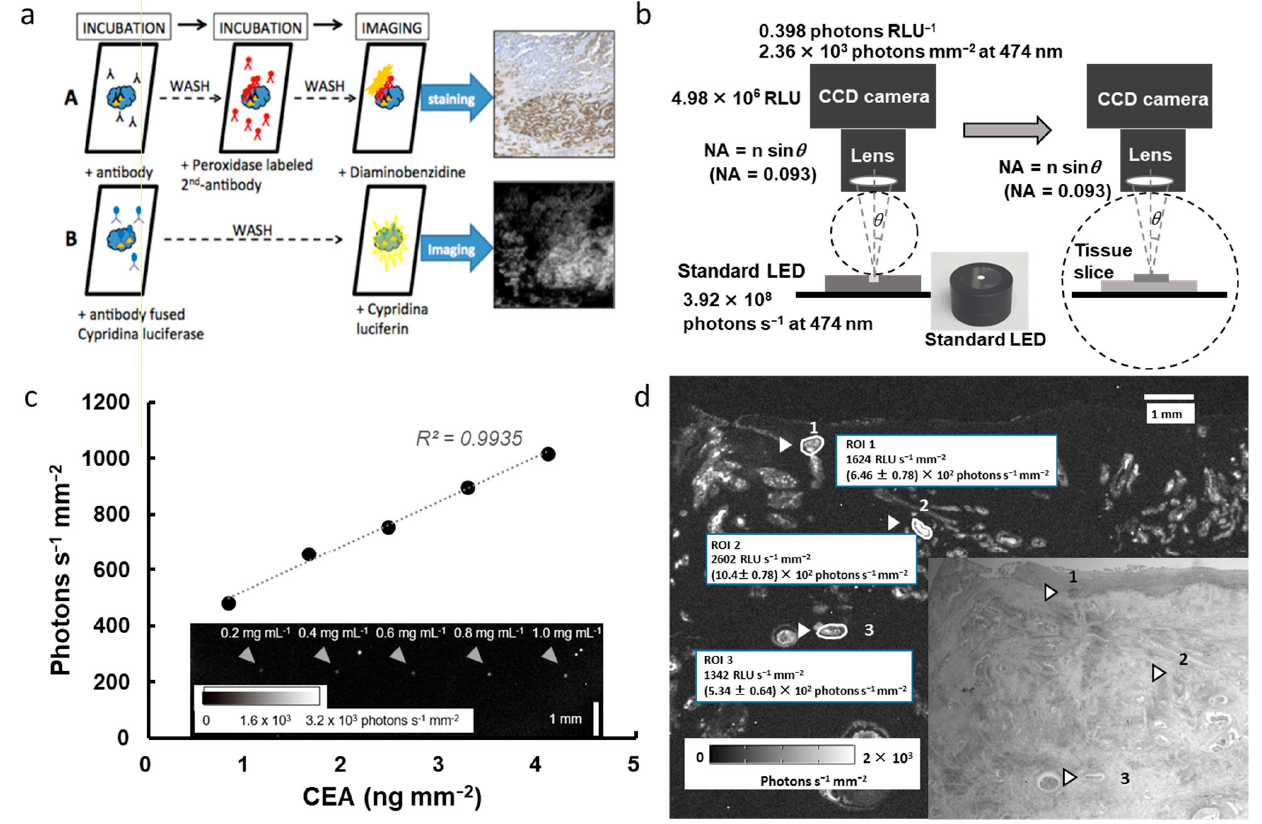
Figure 5. Outline of bioluminescence immunohistochemistry from procedure to results (refs. [69,71]). ( a ) Procedure for immunohistochemical staining of serial paraffin sections using indirect peroxidase labeling methods (A) and direct antibody-fused luciferase labeling (B). ( b ) Schematic illustrations of the setup and procedure for calibrating the bioluminescence imaging system based on the LED-based optical reference light source. At 474 nm, the photon flux of the LED-based optical reference light source contained 2.36 × 10 8 photons s − 1 , corresponding to 4.98 × 10 6 RLU on the CCD camera. ( c ) Calibration curve between antigen count and photon numbers in the antigen-dotted protein microarray. ( d ) Absolute bioluminescence imaging immunohistochemistry of surgical pathological specimens and light imaging (inside photo). Antigen distribution and determination of photon number of three randomly selected spots in the colon cancer (shown in white).